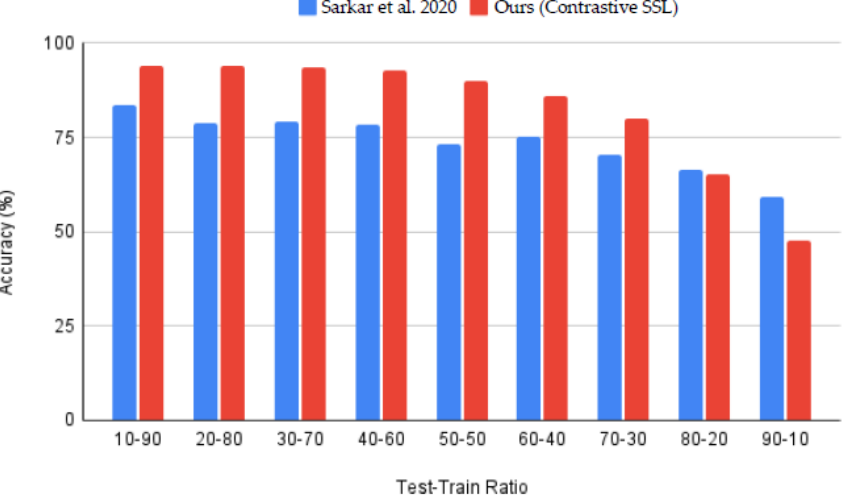
Figure 4. Contrastive SSL (proposed) vs. non-contrastive SSL [8] for varying test-train splits on the WESAD